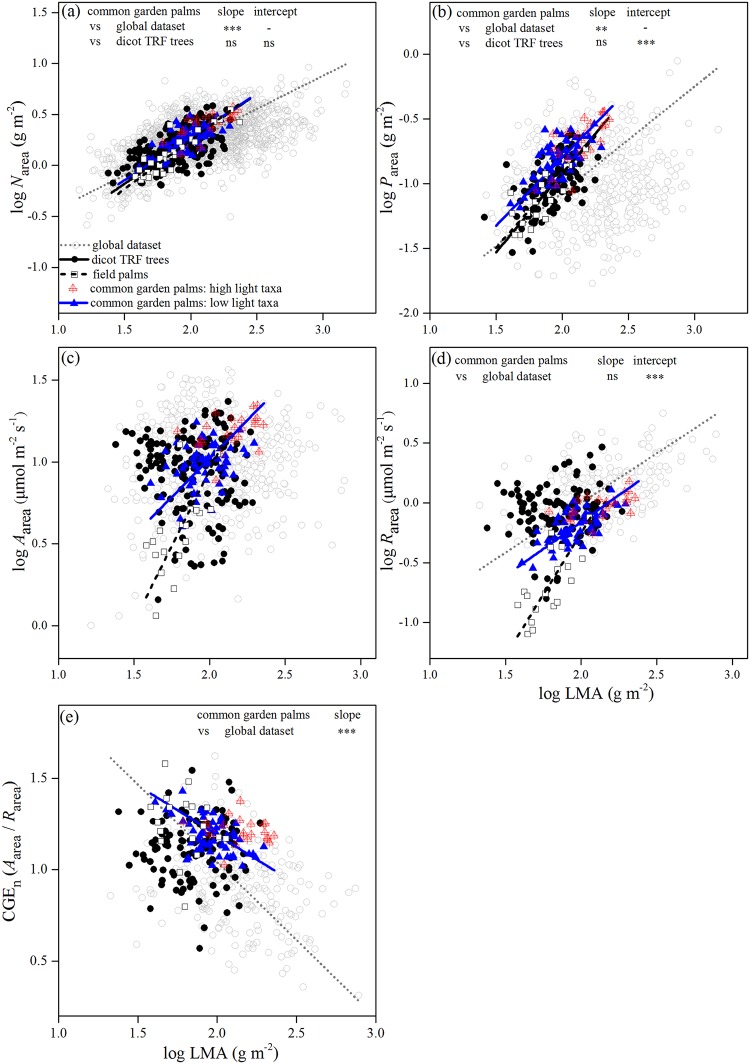
Trait relationships with leaf mass per area (LMA) as a variable across common garden palms, field palms, species from a global dataset and dicotyledonous broad-leaved trees in tropical rain forests (dicot TRF trees).(a) Area-based nitrogen concentration (N
area), (b) area-based phosphorus concentration (P
area), (c) area-based maximum photosynthetic rate (A
area), (d) area-based dark respiration (R
area), (e) net carbon gain efficiency (CGEn). Standardized major axis (SMA) regression lines are only shown for significant relationships. The differences in SMA regression slope and intercept between common garden palms and two other non-palm datasets are indicated (see S4 Table for the differences between field palms and two other non-palm datasets). ns, P > 0.05, ** P < 0.01, *** P < 0.001.